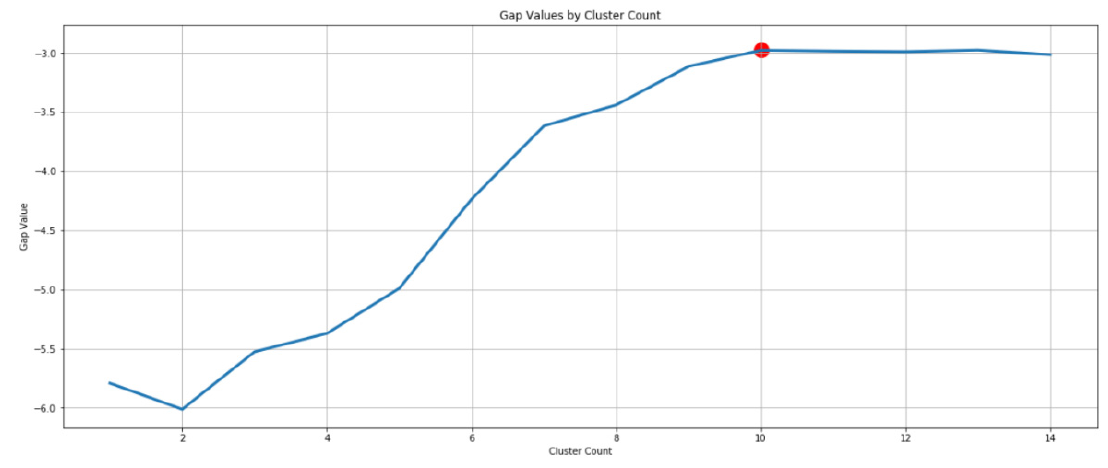
Figure 9. Output of gap statistic. The optical value for clustering was k = 10.